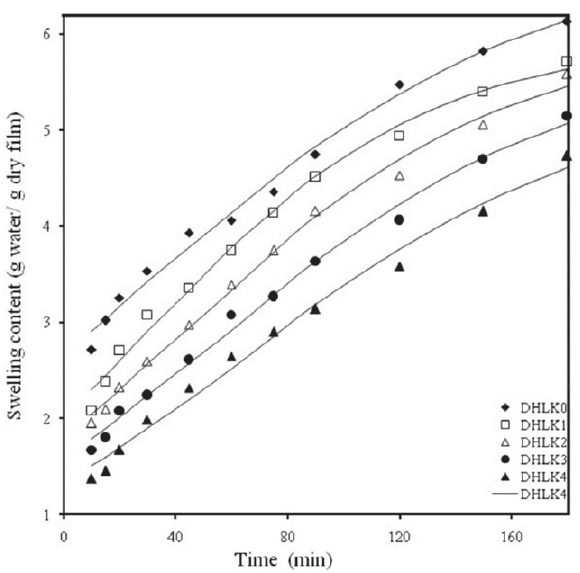
Figure 6. Fitting of the Lag phase sigmoid model of films of HPMC K100LVCR (H L ) matrix with varied kaolin content.